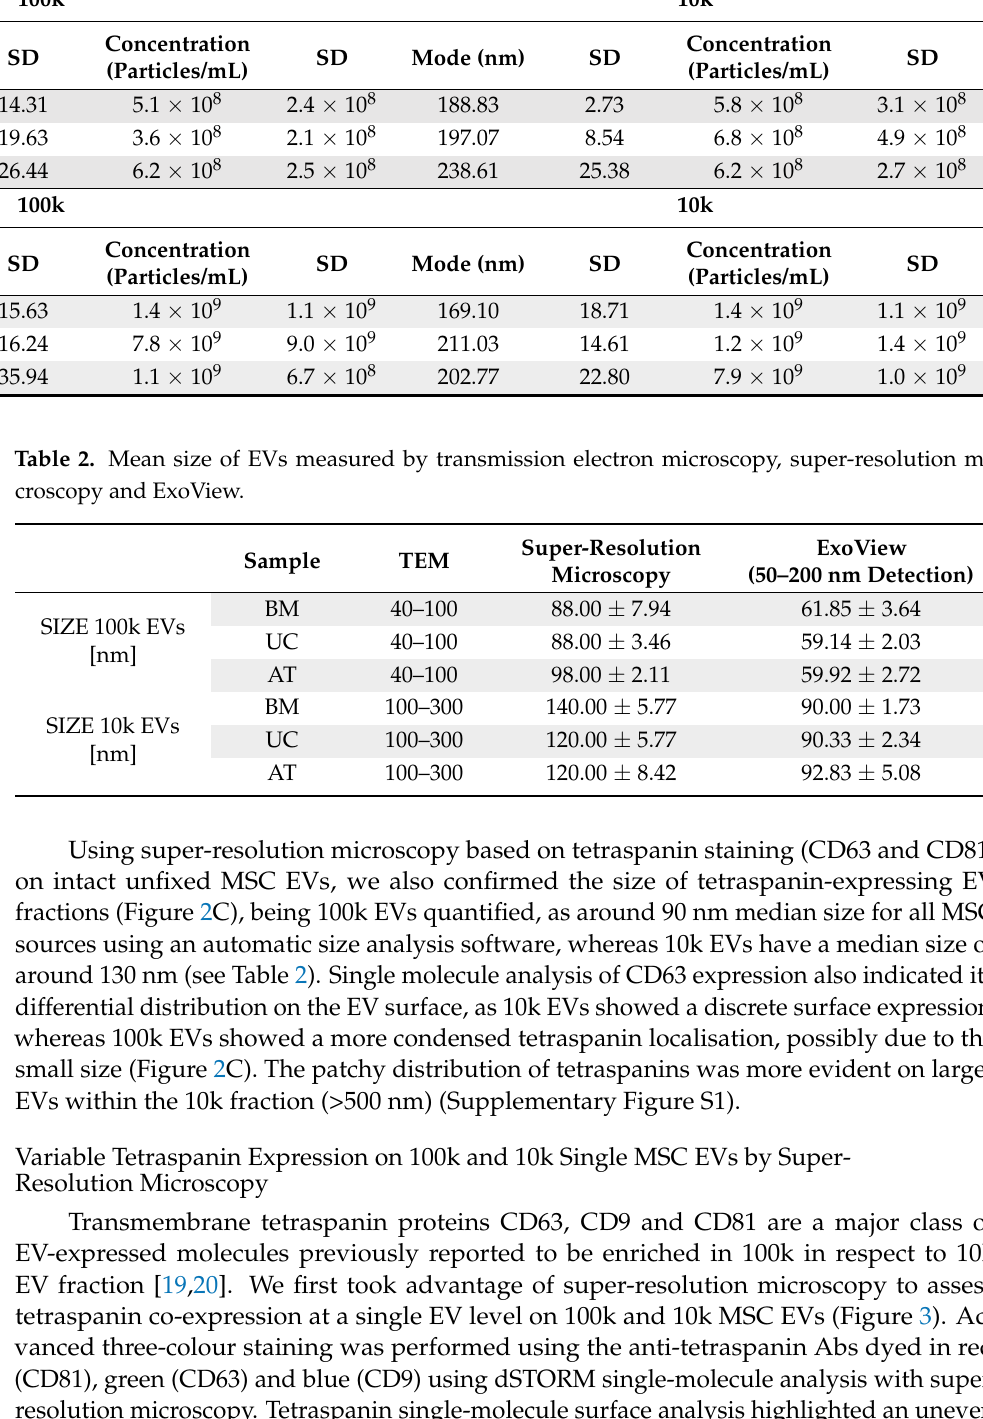
Table 1. Average size and EVs concentration in 1 mL measured by Nanosight. 100k